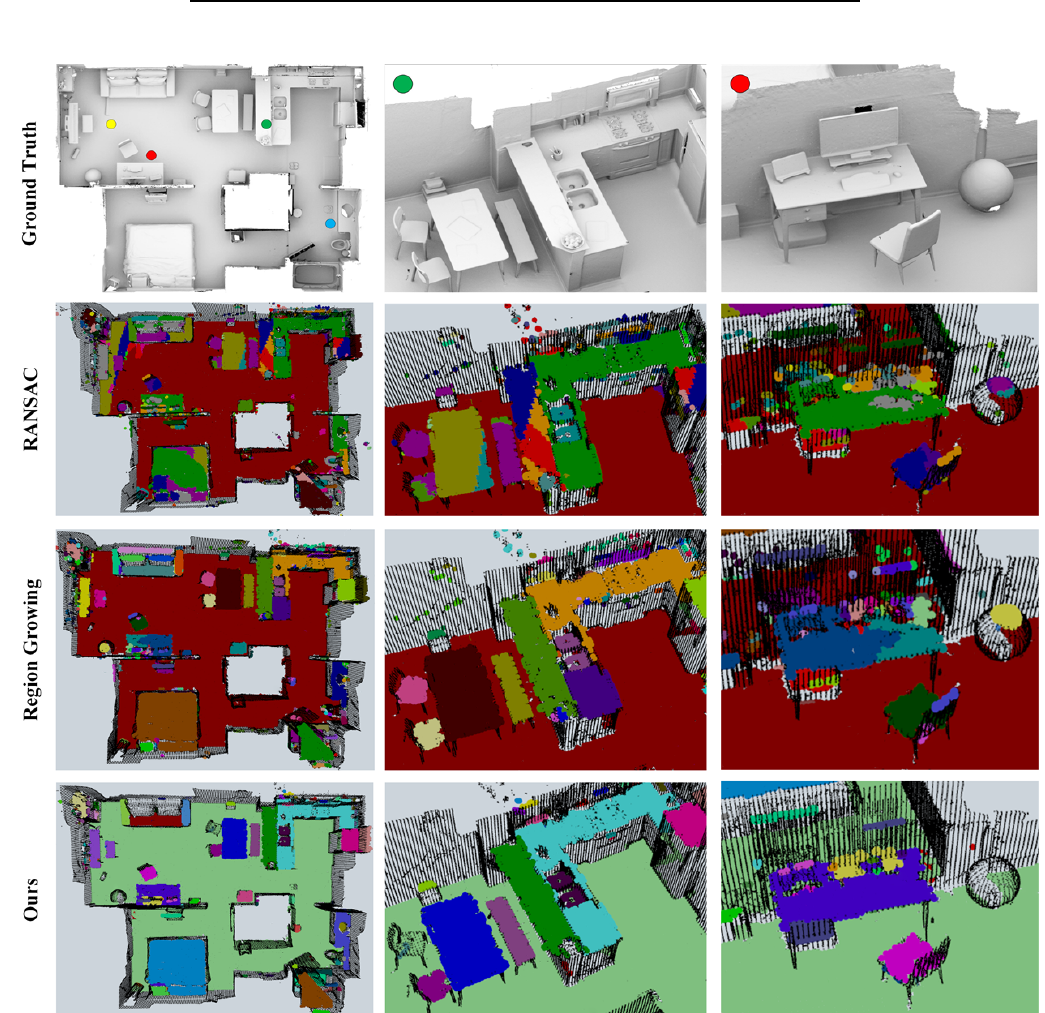
Figure 7. Intermediate results of the apartment scene from Indoor LiDAR-RGBD Scan Dataset. The parameters used in this experiment is detailed in Table 3. The baseline methods suffer from under- and over-segmentation especially for larger surfaces, which are avoided by the proposed method. Meanwhile, the curved surface such as the top surface of the sphere in the third column is successfully filtered out by our refinement